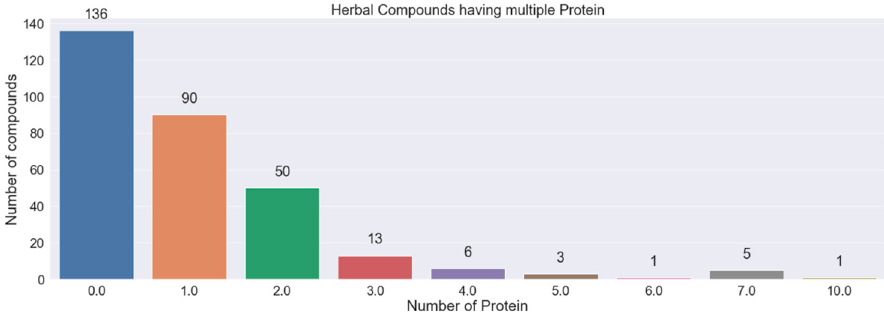
Figure 7. Details of the number of herbal compounds that interact with the protein set predicted by SAE-DNN with circular fingerprint datasets.